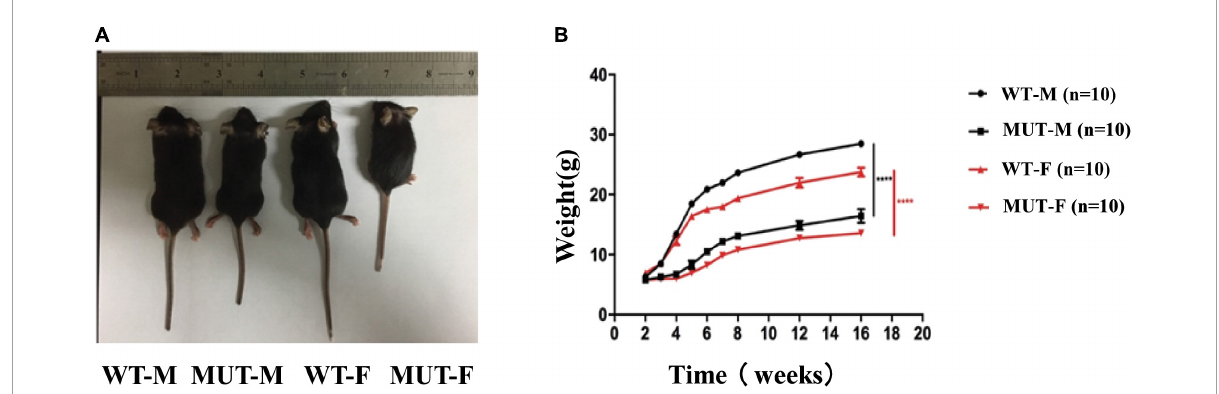
FIGURE1 The female mice carrying the homologous mutation of Timm8a1-I23fs49X exhibited less gain of weight. (A) Mice at the age of 4–5 weeks [from left to right: wild-type (WT) male, MUT male, WT female, MUT female mouse]. (B) Weekly bodyweight. The Timm8a1 MUT mice were significantly smaller than the WT mice since the 3rd week ( ∗∗∗∗ p < 0.0001).